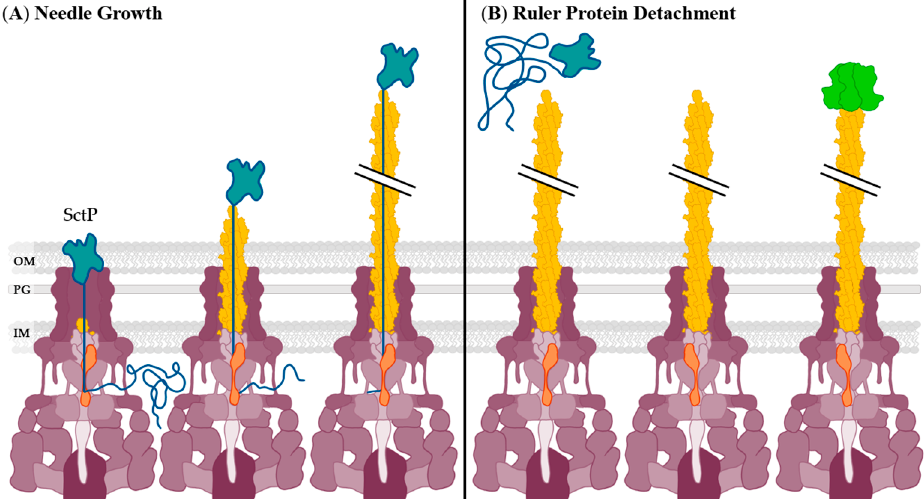
Figure 3. Ruler protein measuring the length of T3SS needle polymerization. ( A ) SS interacts with SctC to signal needle component secretion (SctF, yellow). Ruler protein (SctP, blue) assisting in SctF polymerization. SS acts as a cap to the needle and LS interacts with SctU (orange) as it is threaded through the export apparatus. SctP reaches the full length and SctF polymerization halts; ( B ) LS is released from SctU and SctP is secreted. SctU has a conformational change that activates the injectisome to switch to middle secretion, including the needle tip (green). Modified from [74]. Abbreviations: OM, outer membrane; PG, peptidoglycan; IM, inner membrane.